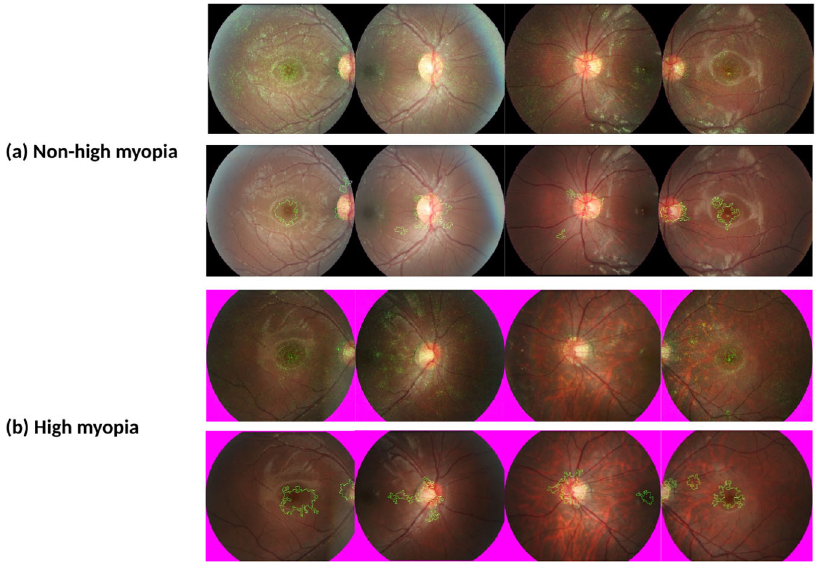
Fig. 4 Saliency heatmaps. Integrated Gradients technique (Top) and post-processed images demonstrating areas of interest through collation of high saliency pixels (Bottom) for a Non-high myopia and b High